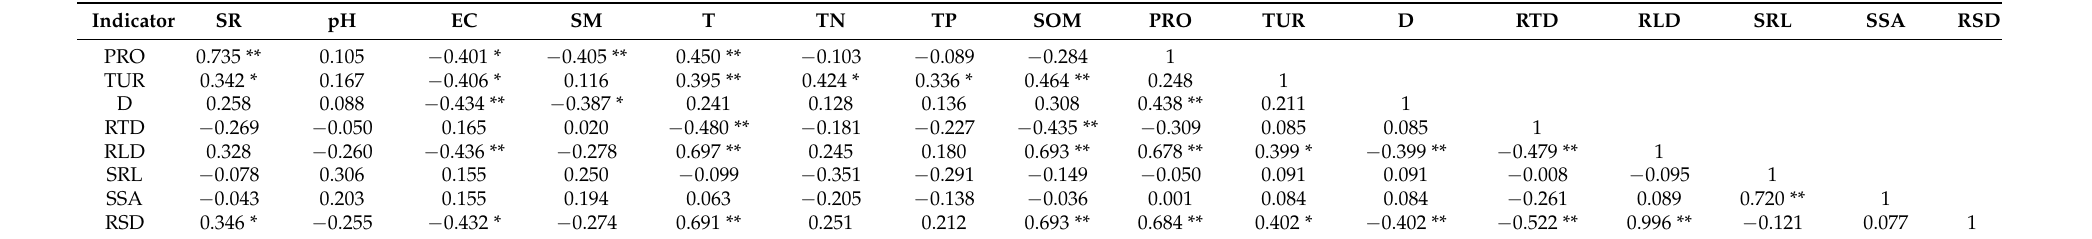
Note: SR: species richness; EC: electrical conductivity; SM: soil moisture; T: temperature; SOM: soil organic matter; TN: total N; TP: total P; PRO: productive; TUR: turnover; D: fine root diameter; RTD: root tissue density; RLD: root length density; SRL: specific root length; SSA: specific surface area; RSD: root surface area density. * At 0.05 level (double side) significant correlation, ** at 0.01 level (double side) significant